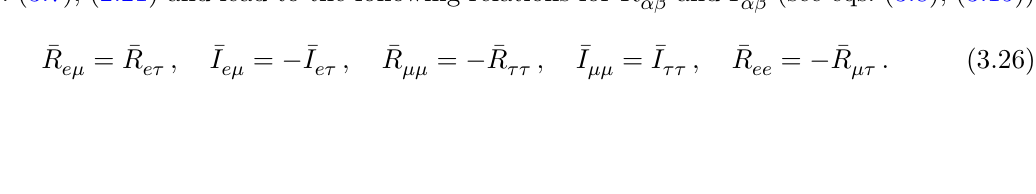
Figure 8 . jh m i j as a function of the lightest neutrino mass ( m ee case) in the case of two sides of equations A, D, E and G being